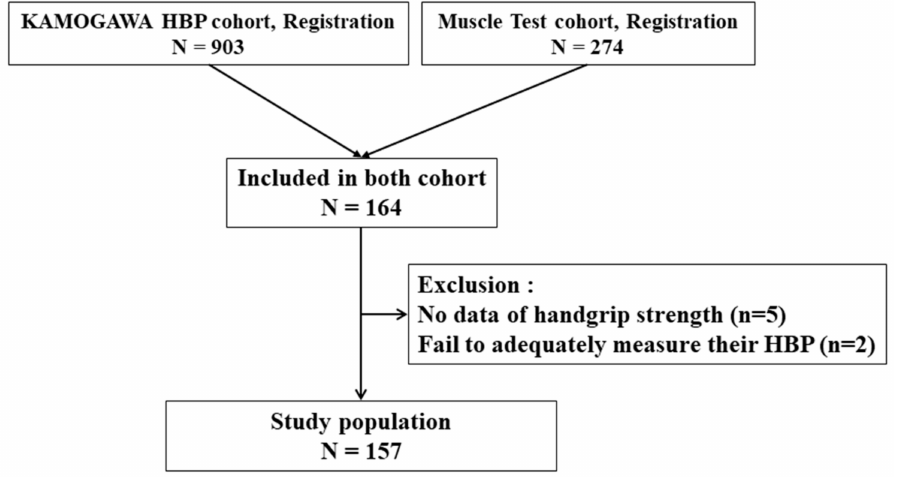
Figure 1. Flow diagram for the KAMOGAWA-HBP